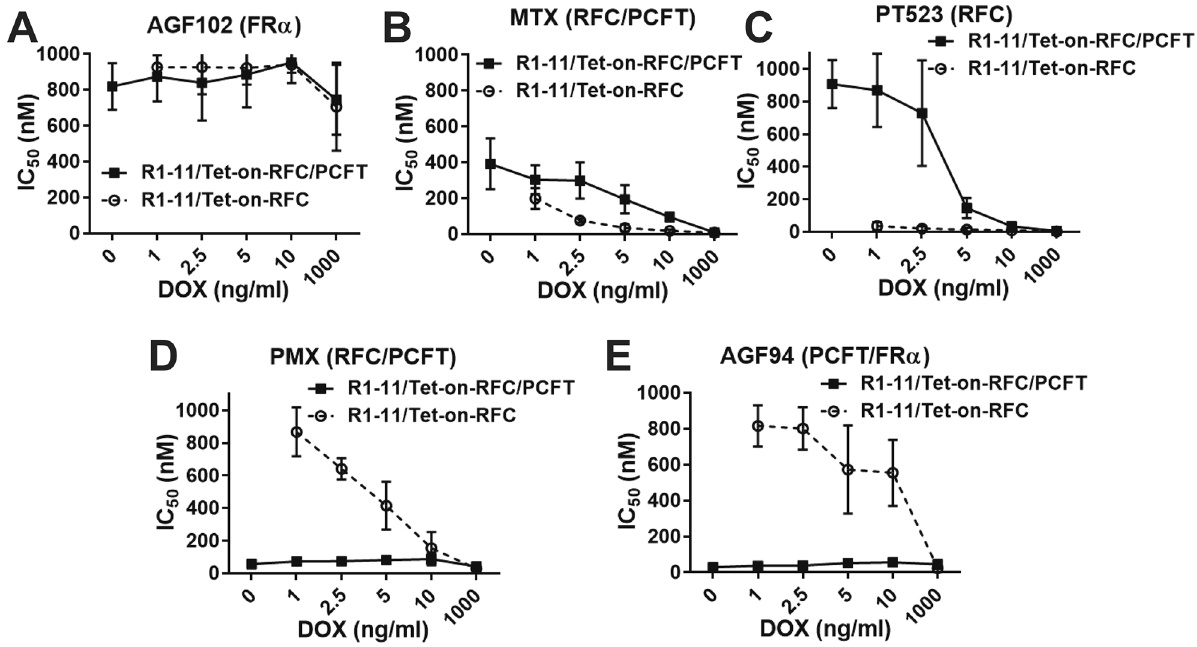
Figure 6. Impact of RFC/PCFT redundancy on drug sensitivity. R1-11/Tet-on-RFC or R1-11/Tet-on-RFC/PCFT cells were plated in 96-well culture plates (4000 cells/well; 200 μl/well) with complete FF RPMI 1640 including 10% dialyzed FBS supplemented with 25 nM LCV. Drugs with different transport specificities were added, with concentrations from 1 to 1000 nM for AGF102 ( A ), MTX ( B ), PT523 ( C ), PMX ( D ), and AGF94 ( E ). Cells were treated over a range of DOX concentrations (0, 1, 2.5, 5, 10 and 1000 ng/ml) and incubated from 96 to120 h (depending on the growth of the cell models) at 37 °C in a CO 2 incubator. Cell viabilities were measured with a fluorescence-based viability assay (CellTiter-Blue; Promega) and a fluorescence plate reader (emission at 590 nm, excitation at 560 nm) for calculating the drug concentrations that inhibit growth by 50% (IC 50 ). Results are shown as mean IC 50 values + /− SDs from 4 to 15 separate